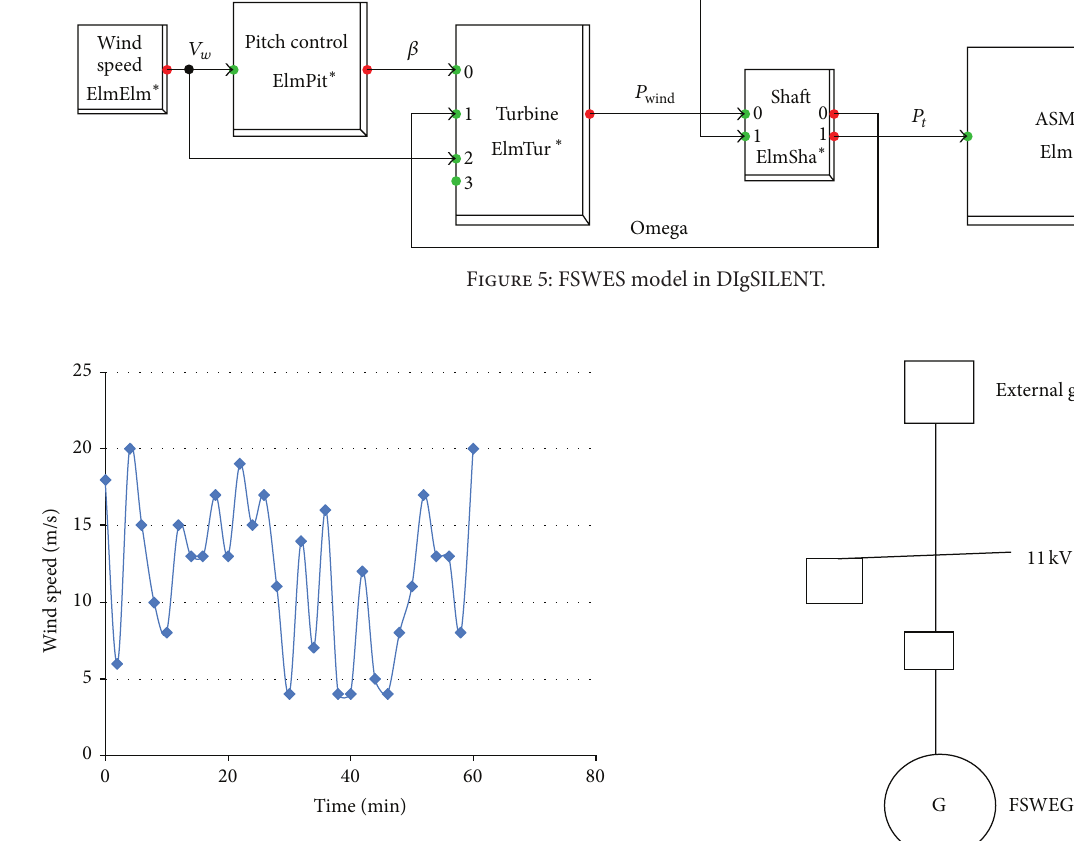
Figure 6: Time series model for wind.